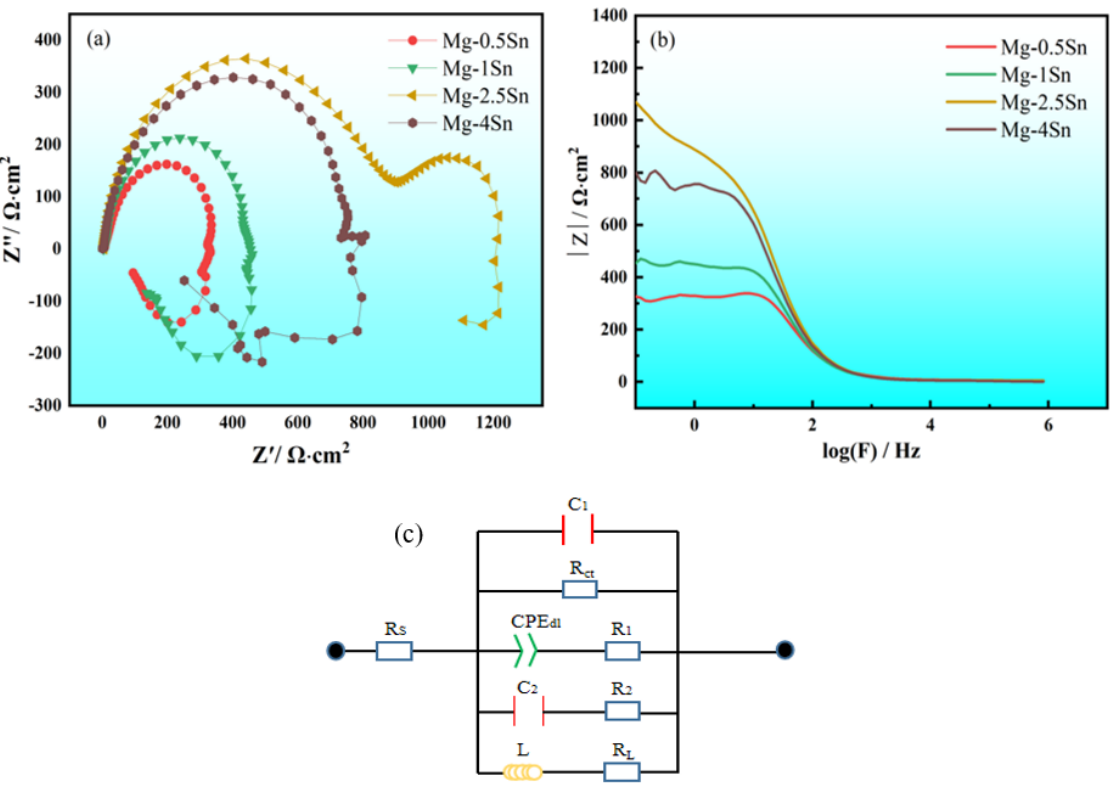
Figure 6. ( a ) EIS Nyquist plots for Mg − x Sn; ( b ) Bode plots of impedance modulus vs. frequency; and ( c ) equivalent circuits used for fitting the EIS spectra.